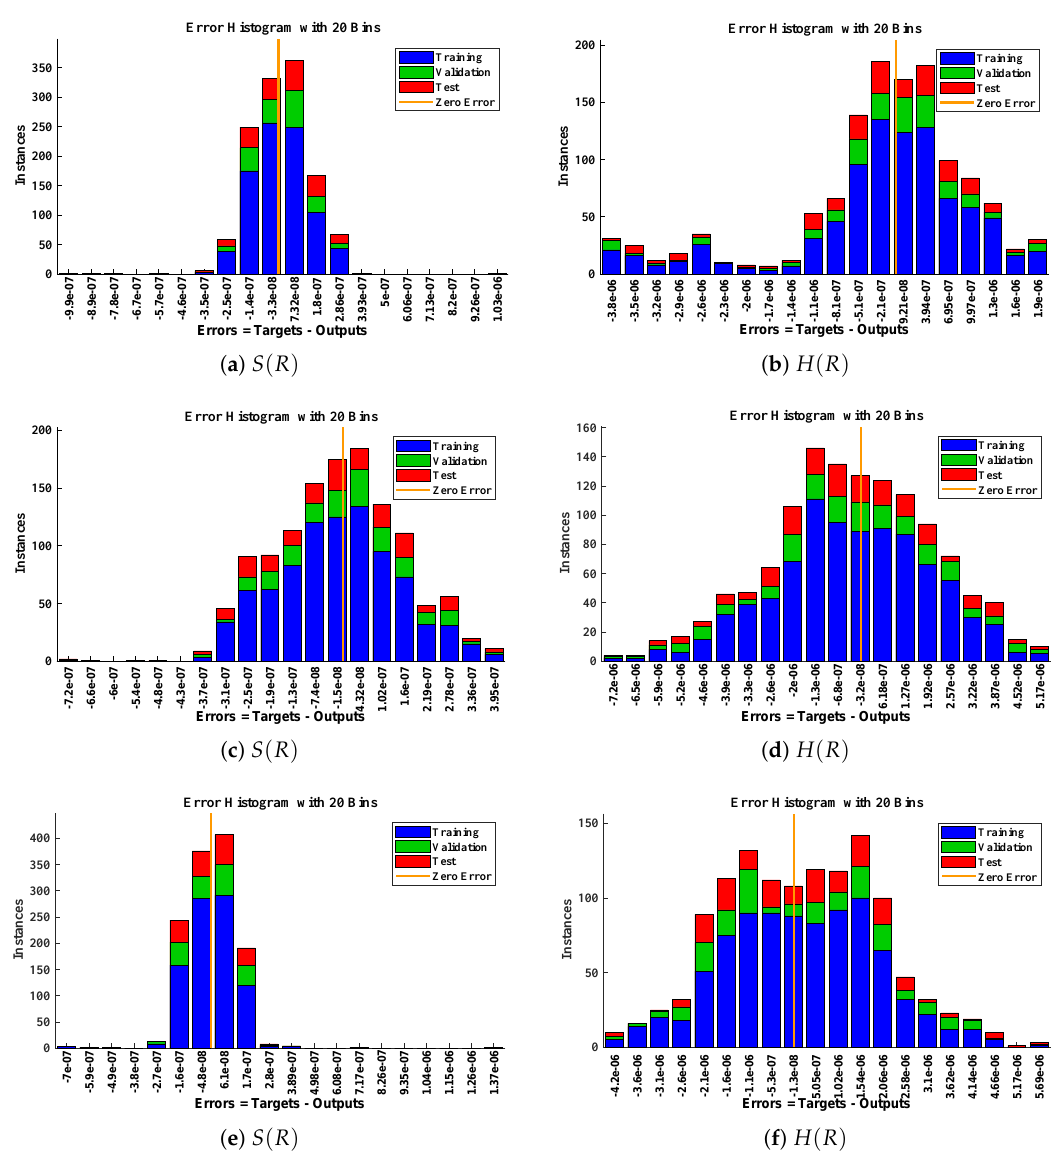
Figure 10. Error histogram analysis between targeted data and approximate solutions for scenario